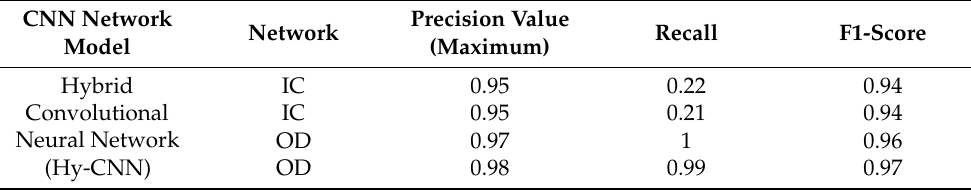
Table 6. Parametric data calculation of precision, F1-Score and